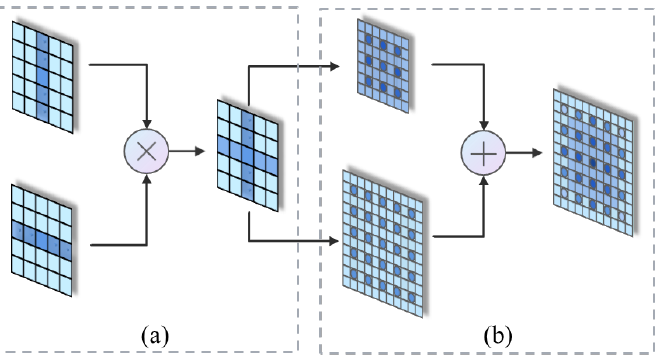
Figure 8. Key point perception module (KPM) schematic diagram. (a) key point location information perception. (b) receptive field enhancement.